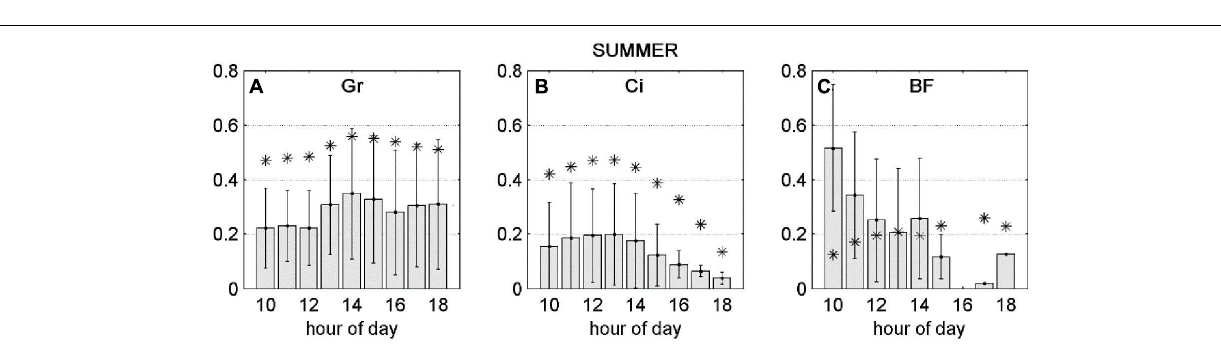
FIGURE 5 | Gray bars: negative fraction of partial derivative of NEP with respect to FO 3st (A,B) or FO 3CUM (C) averaged over hours of day, ± standard deviations. Asterisks: FO 3st (A,B) or FO 3CUM (C) averaged over hours of day. All variables presented in this figure were transformed between 0 and